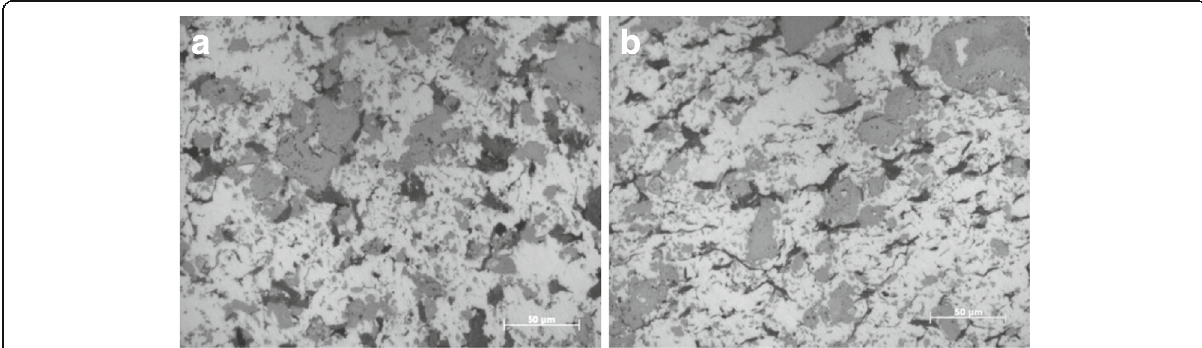
Fig. 3 Metallographic results of sintered nanocomposites with 0.8 wt% graphenes and 0.2 wt% MWCNTs in different directions ( a is parallel to the pressure and b is a perpendicular to the pressure)